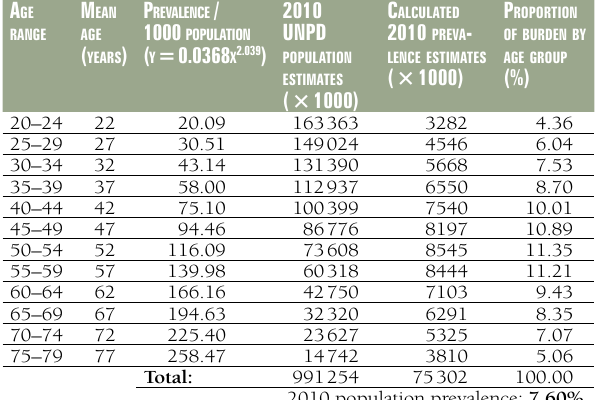
Table 11. Overall prevalence estimates for 2005 a Ge ranGe